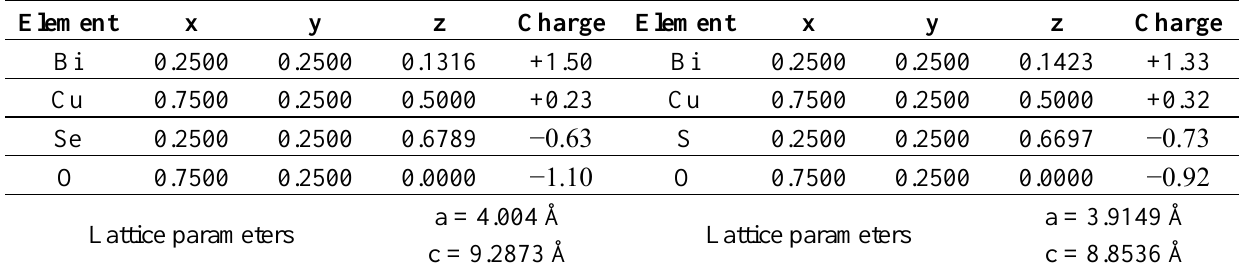
Table 1. Structural parameters and atomic charges obtained by the ab initio